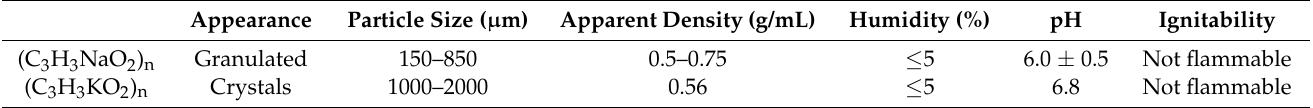
Table 1. Super absorbent polymer (SAP) main characteristics